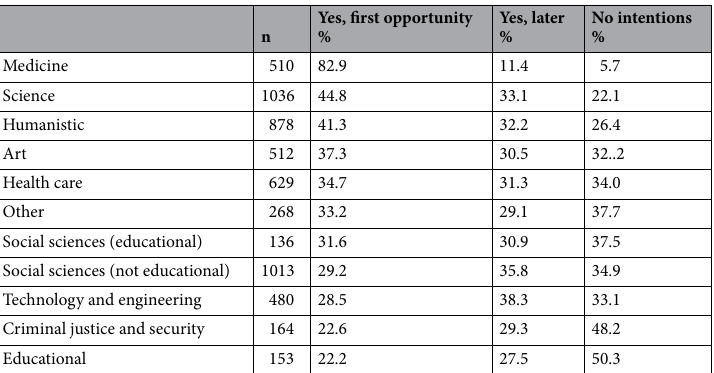
Table 3. Differences between the study streams (N = 5779). The results are ordered by decreasing percentages of those who showed an intention to be vaccinated on the first opportunity. Note Yes, I will vaccinate at the first opportunity. Yes, I will vaccinate, but later. No, I do not intend to be vaccinated.